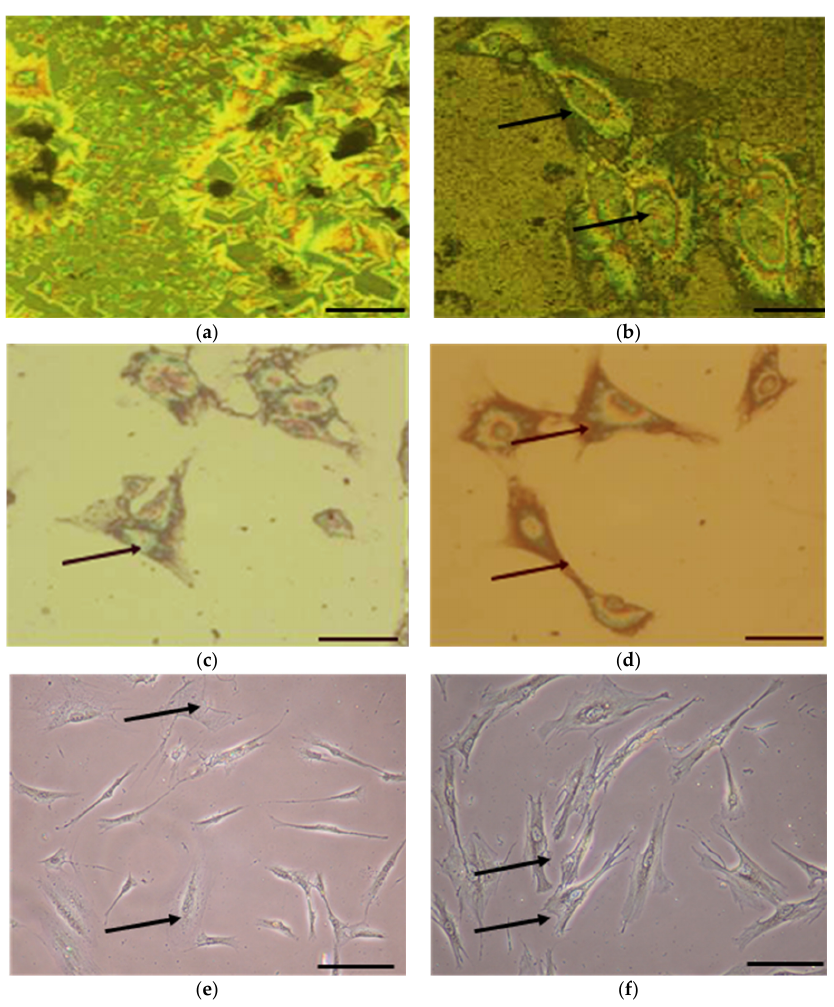
Figure 7. Immunohistochemical detection of Type ‐ I Collagen after 48 h in culture. ( a ) GaAs; ( b ) GaAs ‐ ODT; ( c ) Si; and ( d ) Si ‐ APTES; ( e ) ITO; and ( f ) ITO ‐ ODT (Bar represents 40 μ m).